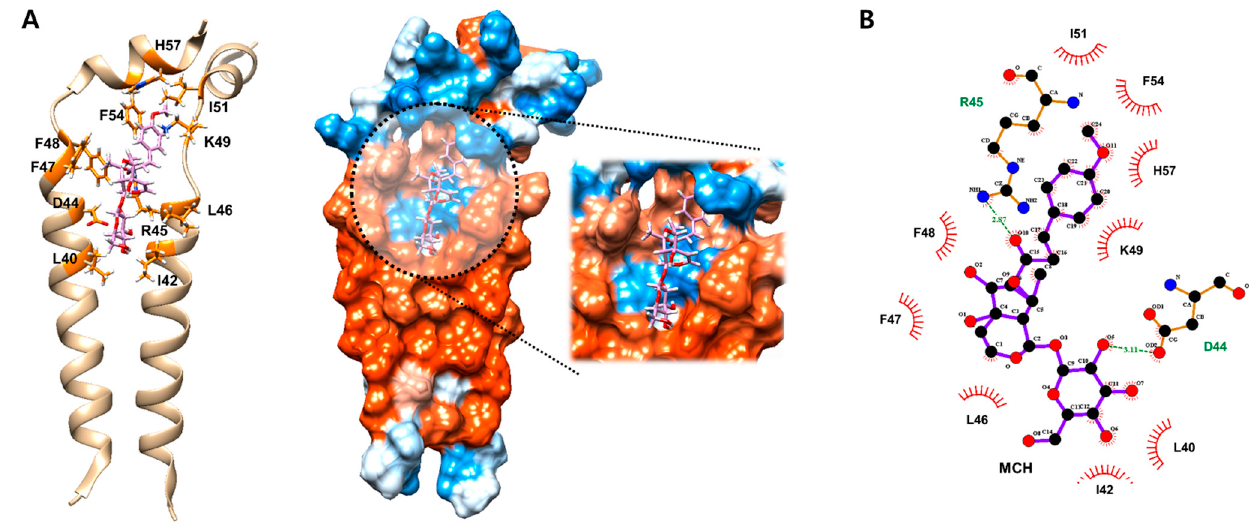
Figure 2 . Docking simulation of MCH on the active site of the M2 protein. ( A , B ) Computational structure prediction for docking between MCH and the M2 protein of influenza virus H1N1. The binding interaction between them was further investigated with LigPlot+ v1.4.5.